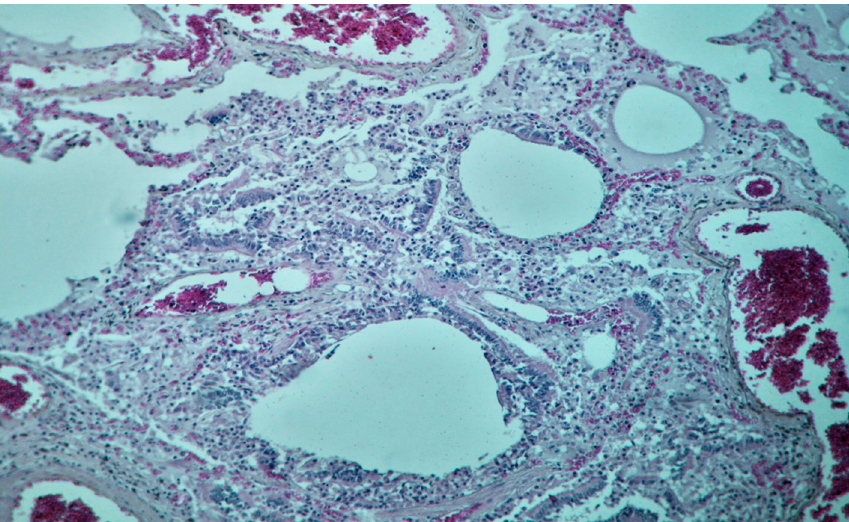
Figure 10. Tissue sample of the left lung parenchyma, from the perihilar region, fixed in a 10% formaldehyde solution, with neutral Ph for a minimum of 72 h. Diagnosis: hematoxylin–eosin (HE)-staining (200×-magnification), bronchiolar lumens with damaged epithelium, neutrophils, and few macrophages. Surrounding alveolar spaces with pale-eosinophilic, finely granular content ( oedema ) , and neutrophilic exudate.